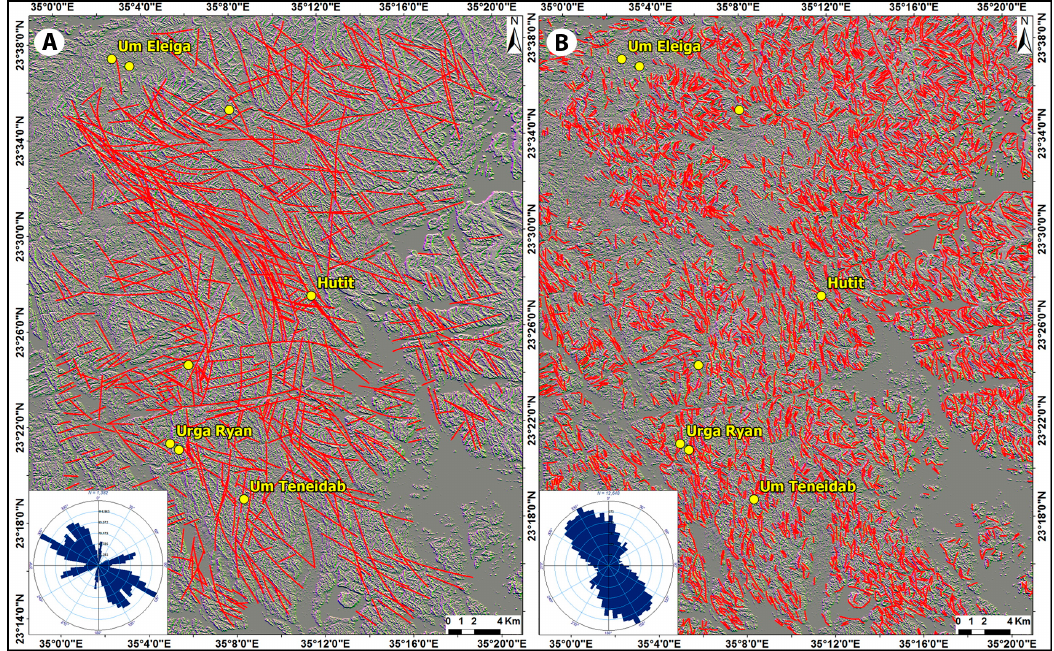
Figure 11. ( A ) Manually extracted lineaments overlaying a FCC image of directional filters (R: 90°, G: 135°, B: 45°) on the Sentinel-1B PC3; ( B ) automatically extracted lineaments superimposed on an FCC (R: 90°, G: 135°, B: 45°) image directionally filtered with PALSAR PC2.